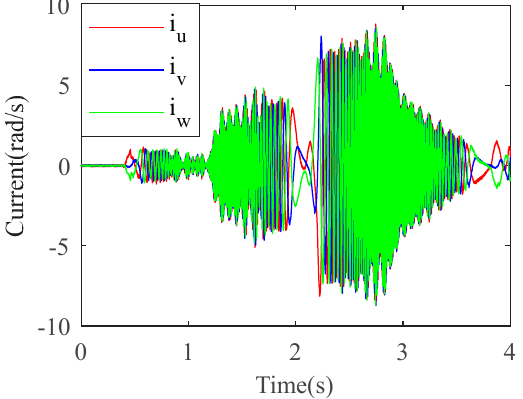
Figure 20. Three-phase current of the motor.